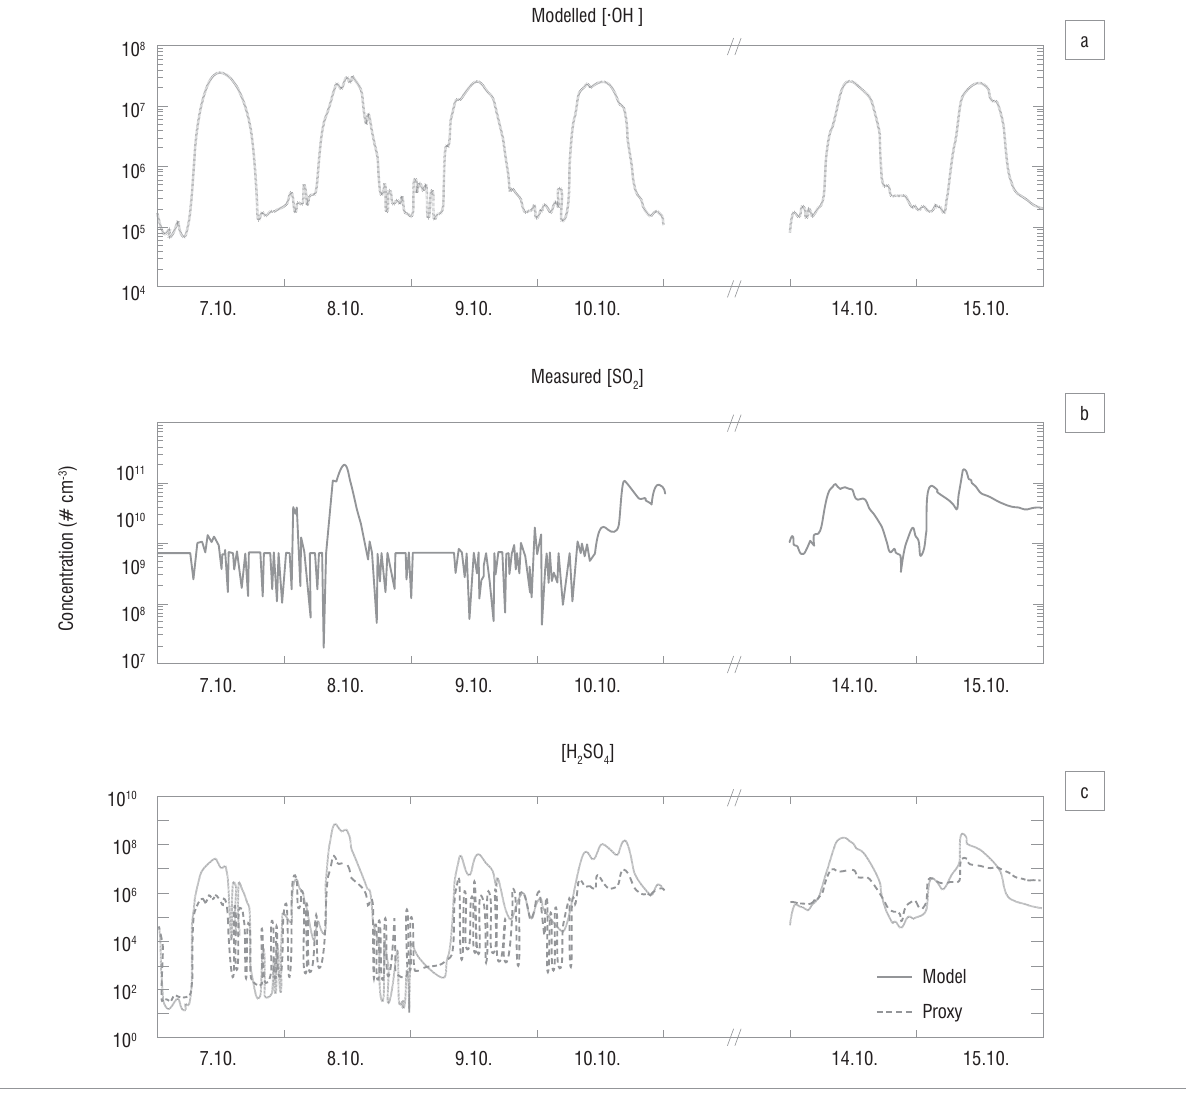
concentration (gap filling applied) and (c) sulphuric acid concentration according to simulations Figure 3: (a) Modelled ·OH concentration, (b) measured SO 2 and calculated by a proxy based on the work by Petäjä et al.